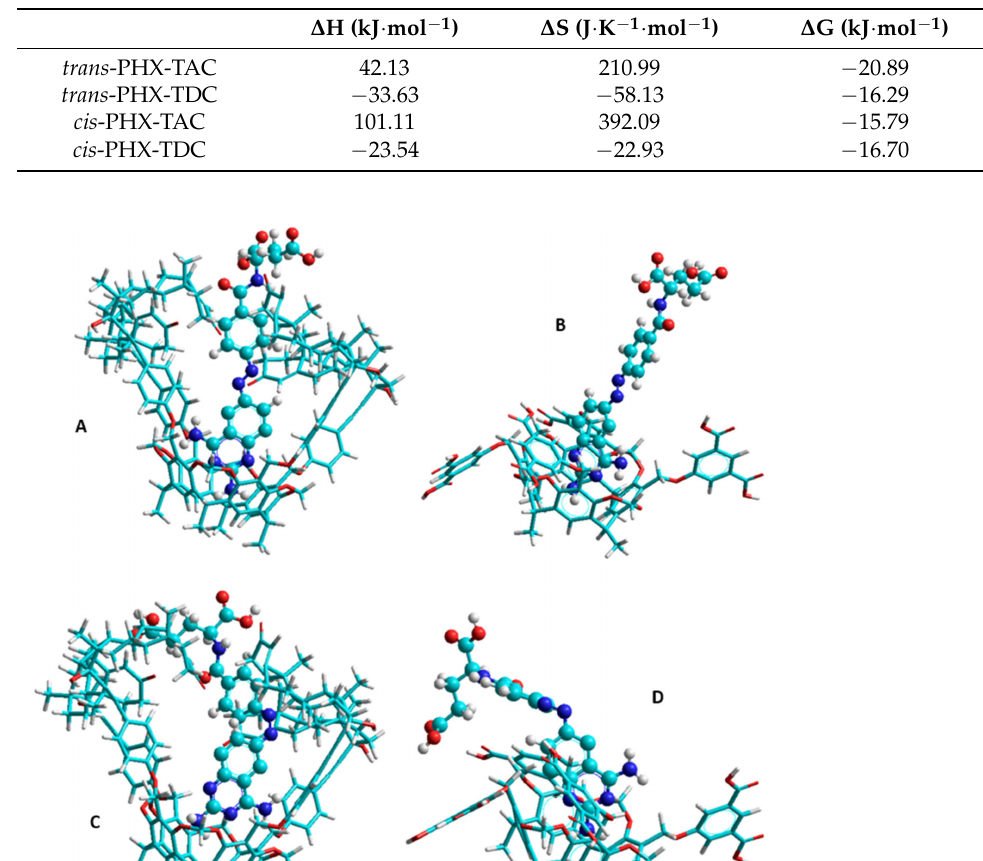
Table 3. Thermodynamic parameters of the complex formation between the cavitands and the isomers of PHX determined at AM1 level applying the TIP3P solvation model. ∆ G values have been calculated for 298 K.